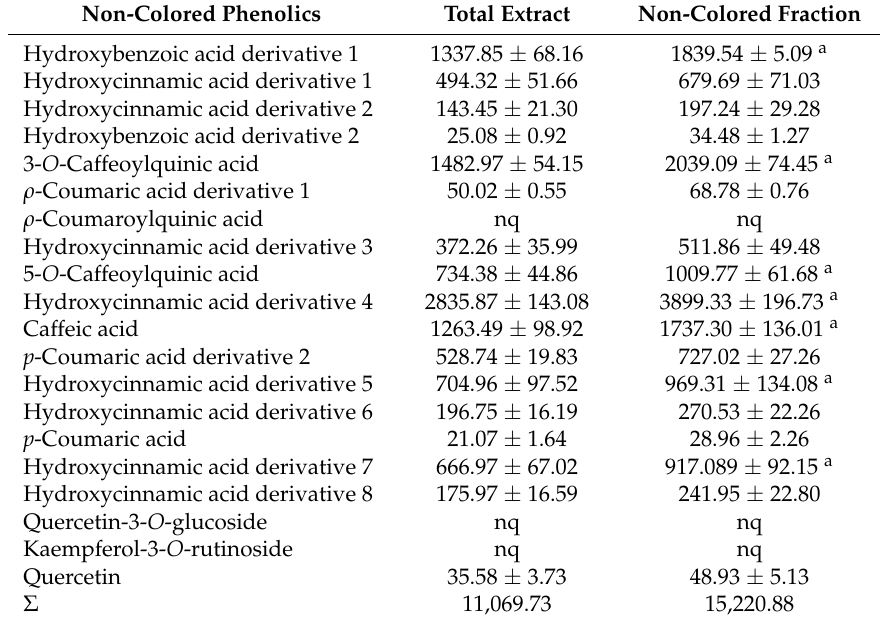
Table 1. Non-colored phenolic contents of Saco sweet cherry extracts ( µ g/g of dried